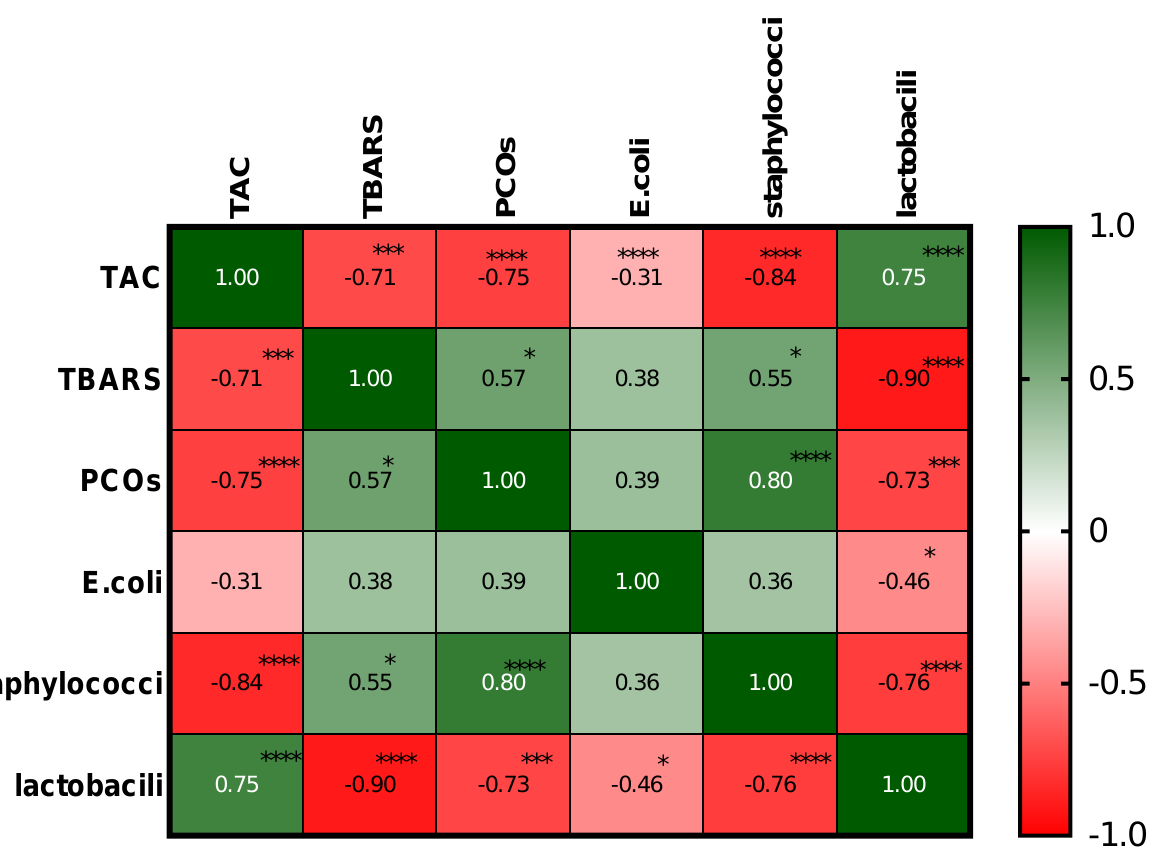
Figure 3. Pearson’s correlations between antioxidant capacity, lipid and protein oxidation biomarkers in liver and intestinal microflora. Each cell contains the correlation coefficient (r 2 ) and statistical level of significance (* p < 0.05; *** p < 0.001; **** p < 0.0001). The negative correlations are highlighted with green and the positive correlations are highlighted with red. The darker the color is, the higher the correlation between variables. Abbreviations: TAC—total antioxidant capacity; TBARS—thiobarbituric reactive species; PCOs—protein carbonyls .